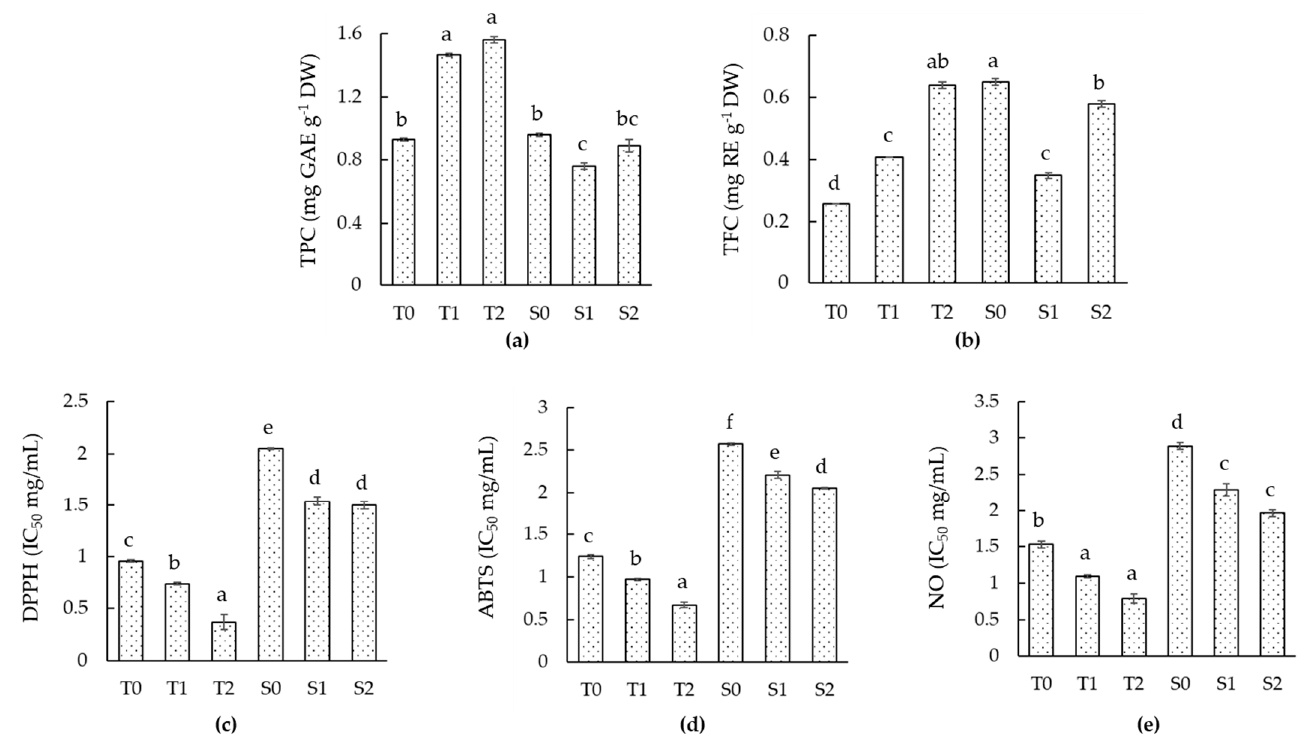
Figure 2. Total phenolic content ( a ), total flavonoid content ( b ), and antioxidant activities ( c – e ) of rice under salinity stress. Different letters in a bar chart indicate significant difference ( p < 0.05) by Tukey’s test. TPC, total phenolic content; GAE, gallic acid equivalent; TFC, total flavonoid content; RE, rutin equivalent; DW, dry weight; DPPH, 2,2 − diphenyl − 1 − picrylhydrazyl assay; ABTS, (2,2 − azinobis − (3 − ethylbenzthiazoline − 6 − sulfonic acid)) assay; NO, nitric oxide assay; T0,